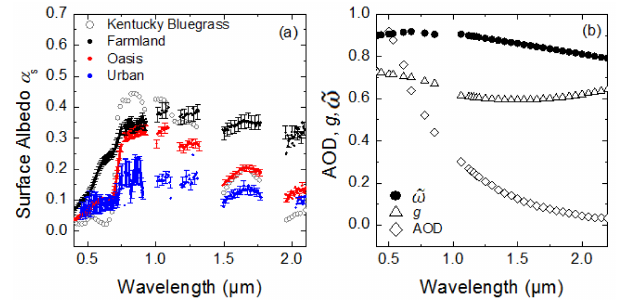
Figure 7. (a) Surface albedo spectra of different surface types. For urban, oasis, and farmland the measurement uncertainty is given as vertical error bars. (b) Spectral characteristic of the optical aerosol properties used in the model